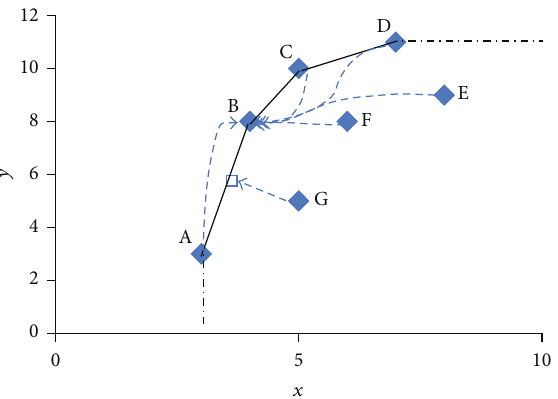
Figure 3: The CRA-BCCI projections onto the frontier line.